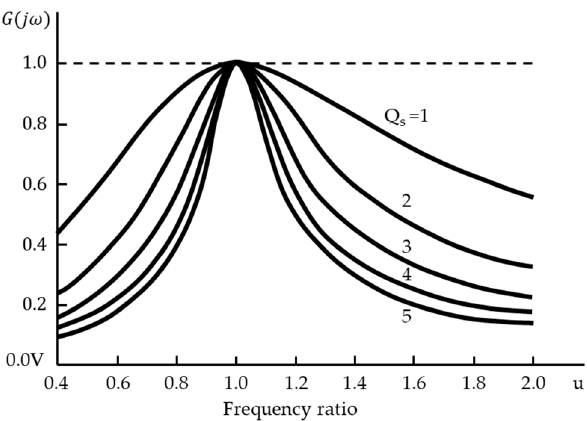
Figure 5. Voltage gain and frequency response characteristics of a series resonant converter.